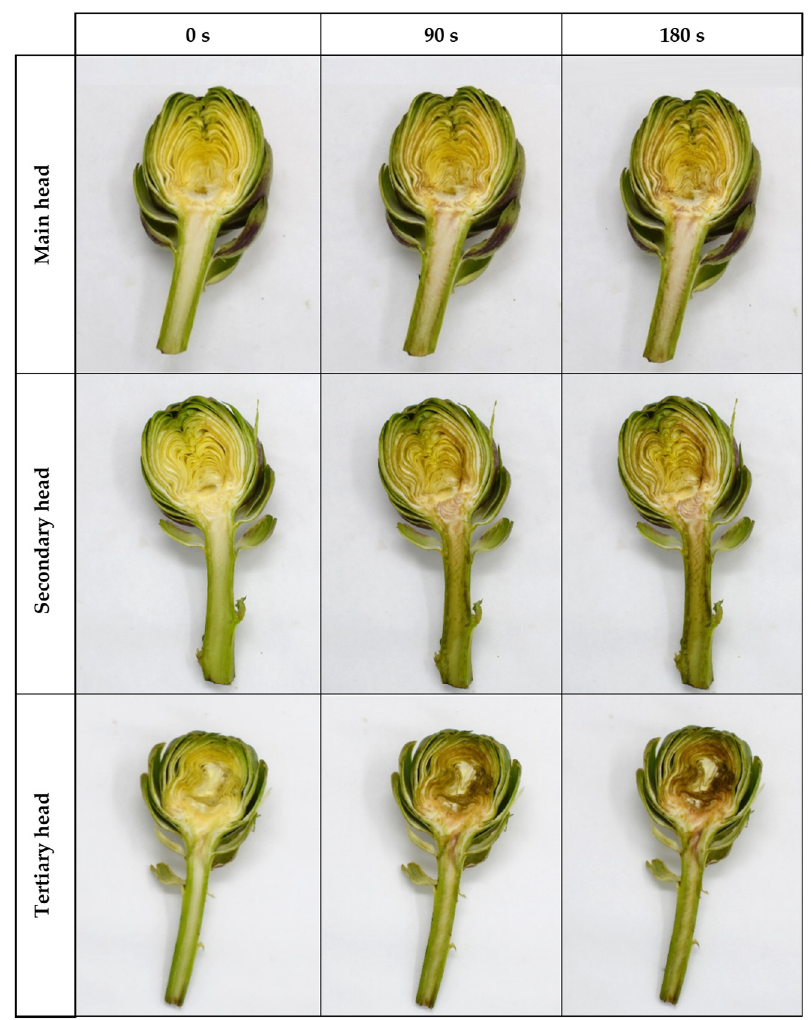
Figure 3. Enzymatic browning process of different flower head orders at time 0 s, 90 s, and 180 s for ‘Lorca’